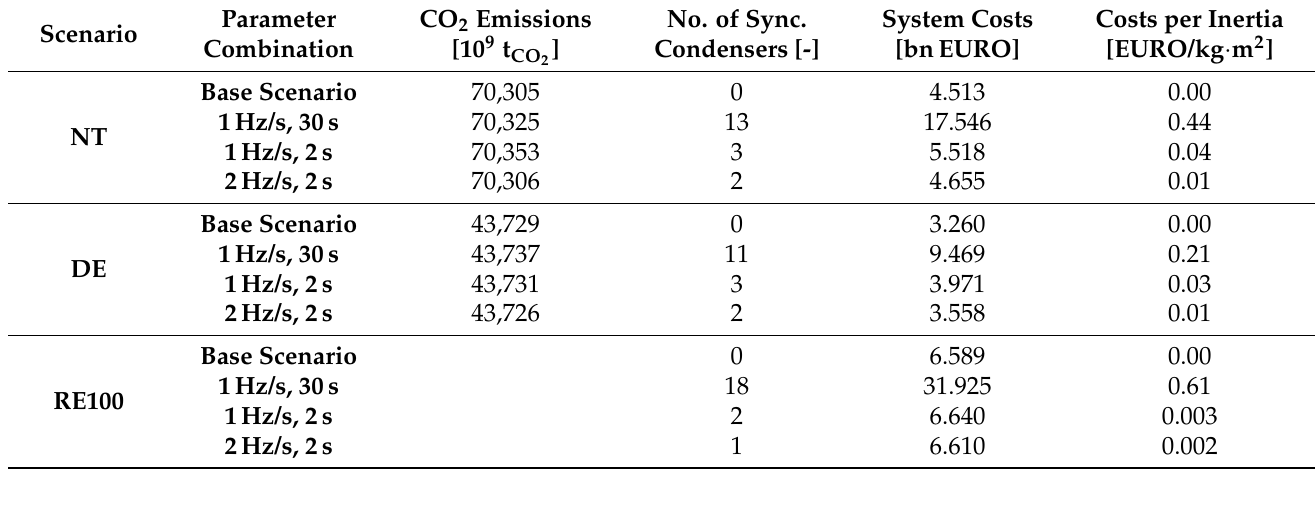
Table 7. Overview of the optimisation results per scenario and parameter combination.